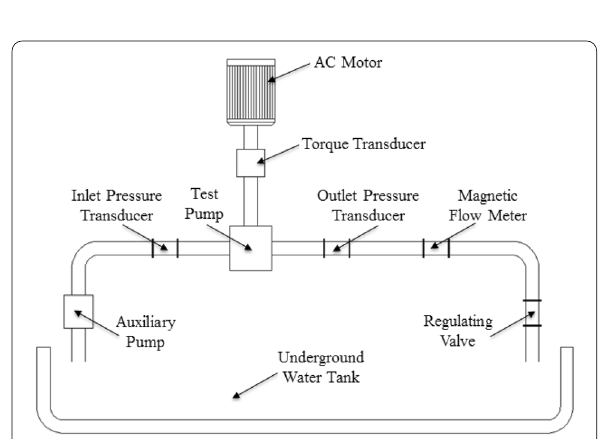
Figure 5 Schematic diagram of the test bench for the